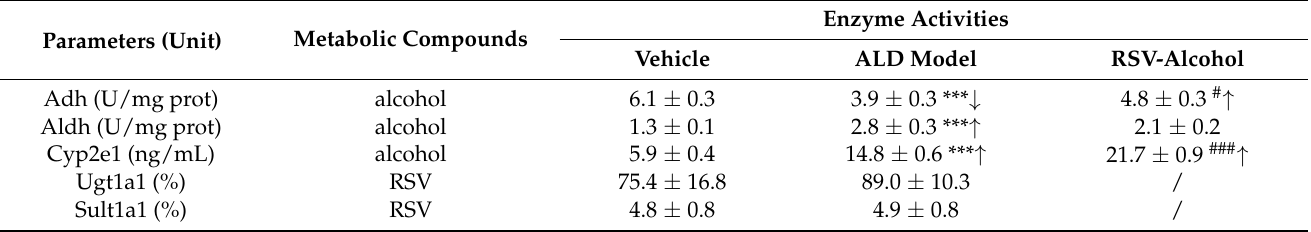
Table 5. Comparison of metabolizing enzyme activities for alcohol and resveratrol among the